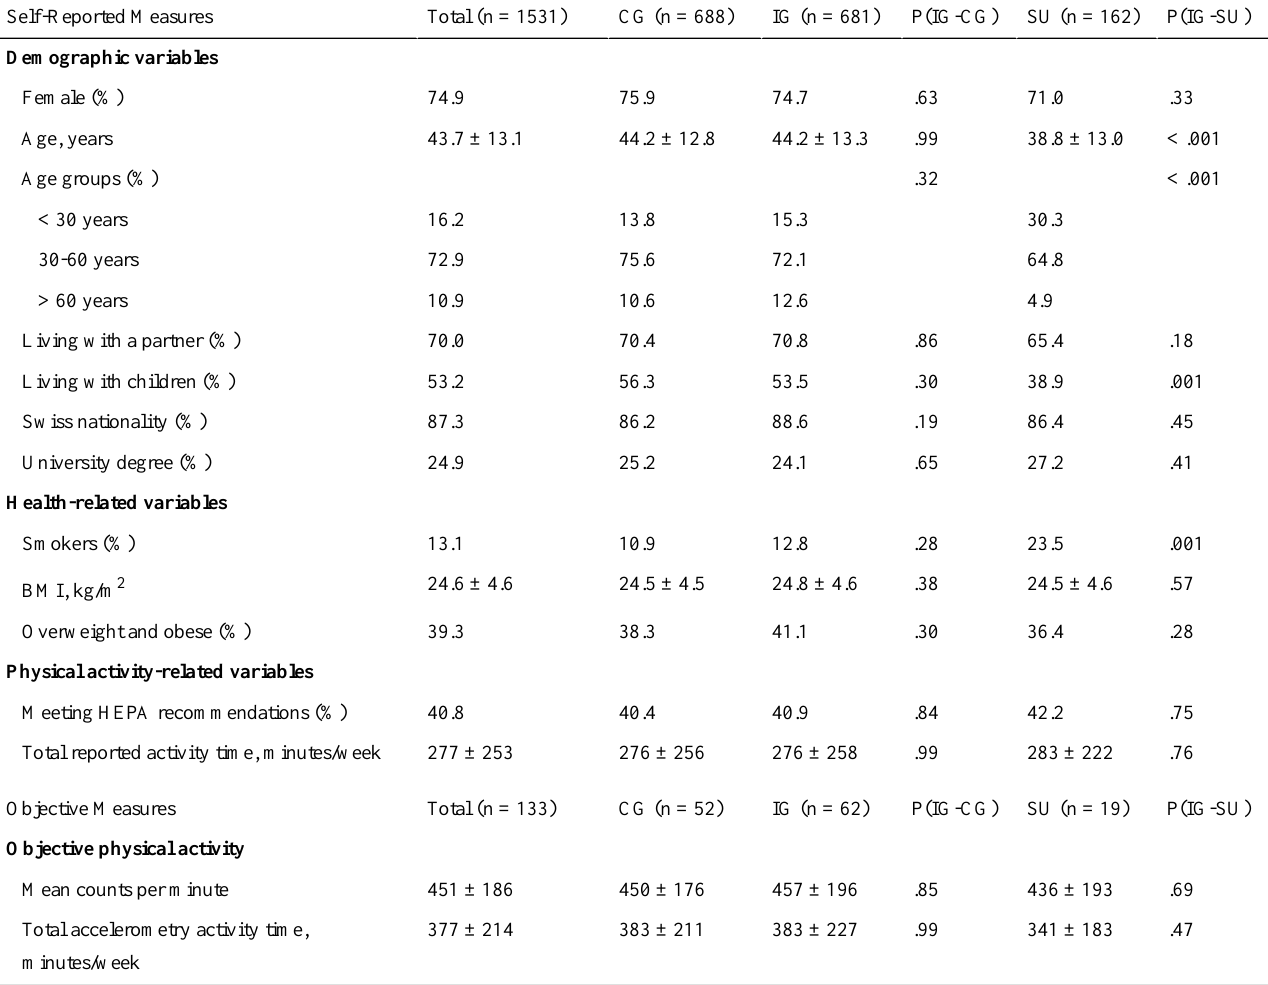
Table 1. Characteristics of participants at baseline according to group